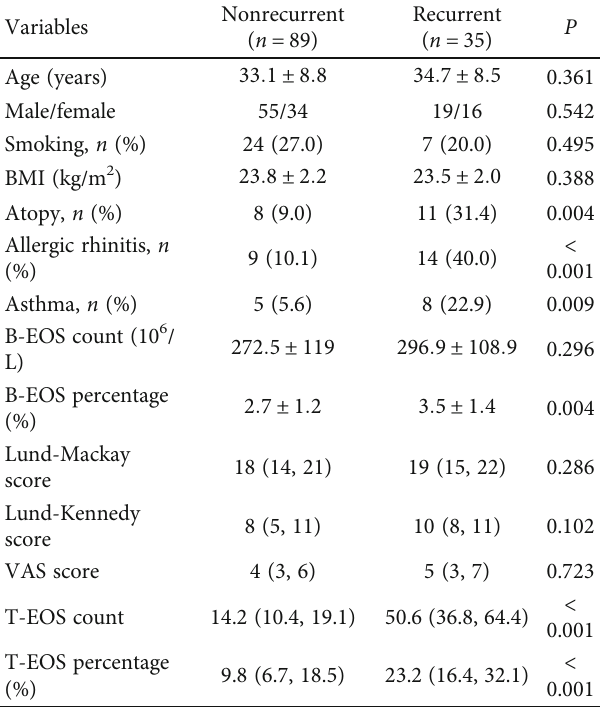
Table 5: The demographic and clinical characteristics between the nonrecurrent and recurrent